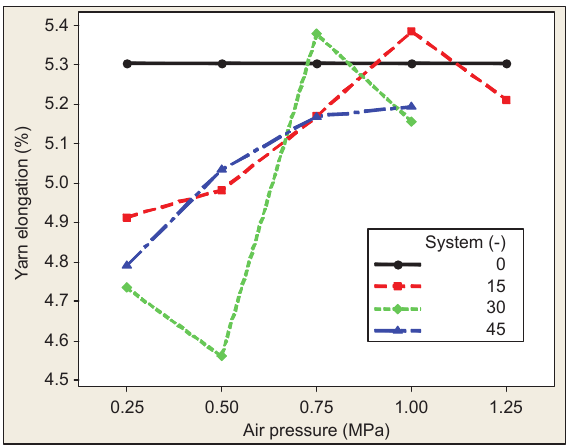
Figure 11 Yarn elongation results.